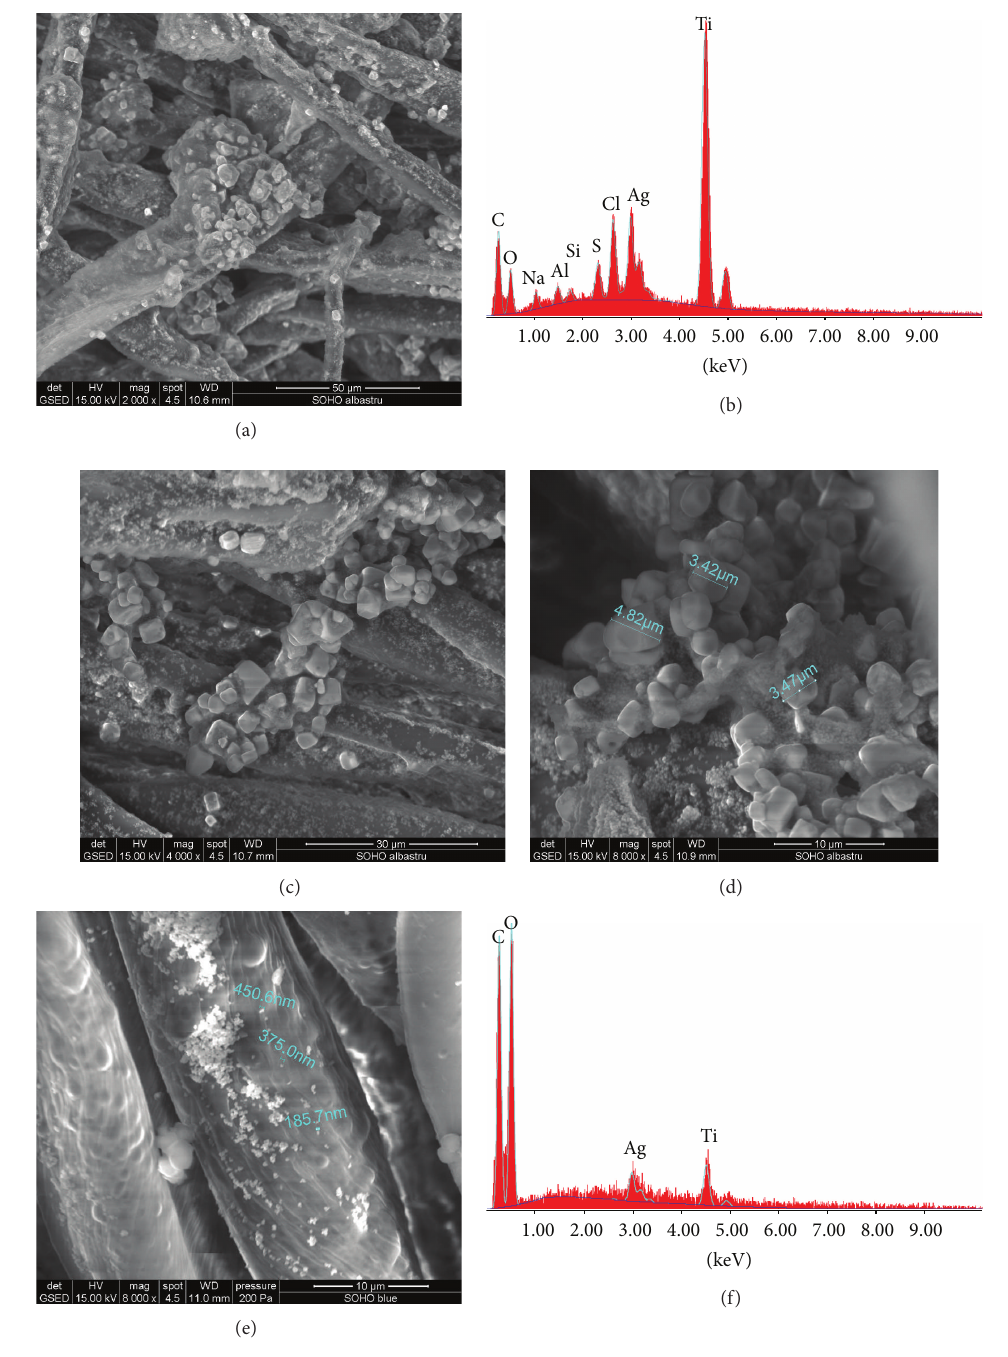
Figure 3: SEM and EDAX images for sample Ib s (antimicrobial finished plasma functionalized type I bleu cotton 100%): (a) SEM image for sample Ibs at resolution × 2000, (b) EDAX image for sample Ibs, (c) SEM image for sample Ib at resolution × 4000, (d) SEM image for